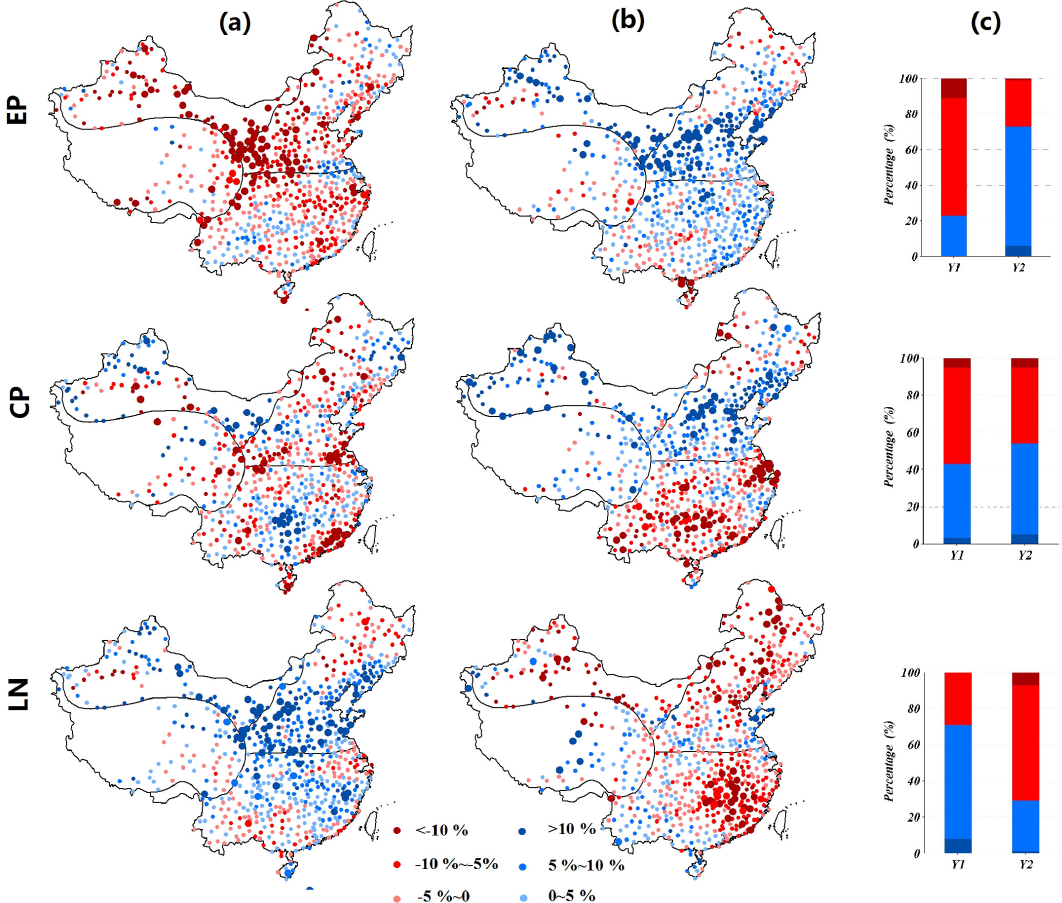
Figure 2. Anomalies of annual precipitation in developing years (a) and decaying years (b) of EP, CP, and LN phases. Stations experiencing significant anomalies are represented by large points. The percentage of stations experiencing increases or decreases in the number of rainfall anomalies are shown in (c) , with significant increase (blue), increase (light blue), decrease (light red), and significant decrease (red). Y1 and Y2 represent developing years and decaying years,